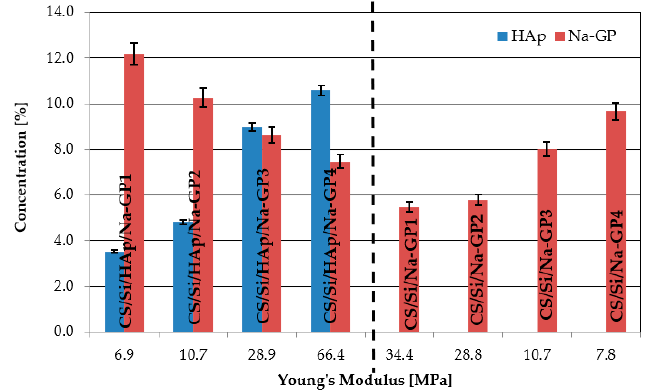
Figure 4. Influence of HAp and Na-GP concentrations on Young’s modulus (labels above each composite) for drying samples at 100 °C.